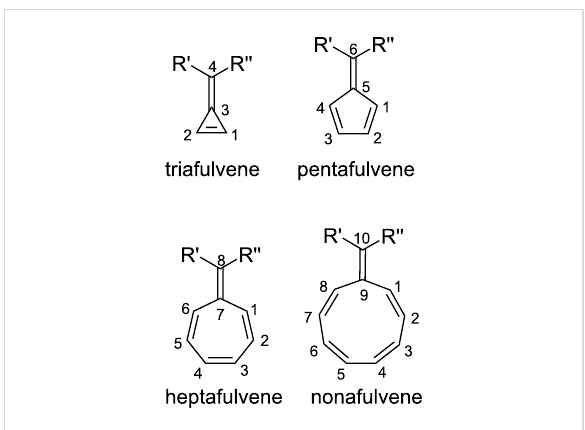
Figure 1: General structure of fulvenes, named according to the num- ber of carbon atoms in their ring. Whilst fulvenes have been numbered using several different systems, Chemical Abstracts nomenclature is used throughout this article [34].